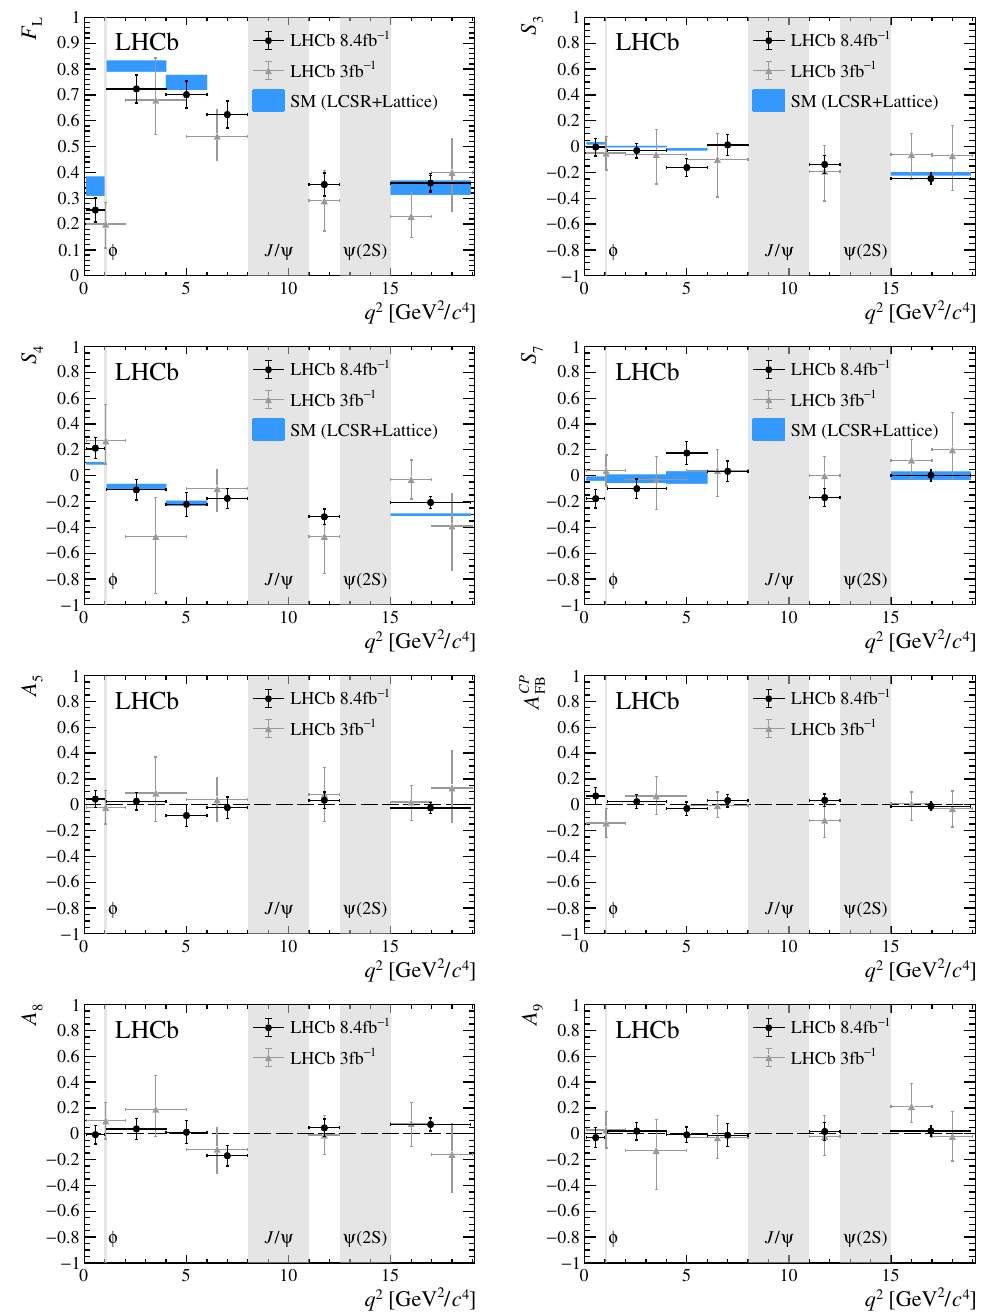
Figure 3 . CP -averaged angular observables F L and S 3 , 4 , 7 and CP -asymmetries A CP shown by black crosses, overlaid with the SM prediction [23–26] as blue boxes, where available. The grey crosses indicate the results from ref. [4]. The grey bands indicate the regions of the charmonium resonances and the B 0 → φφ s